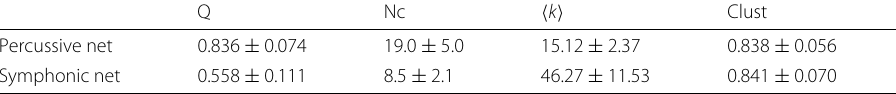
Table 1 Average of topological properties of 60 percussive and symphonic networks